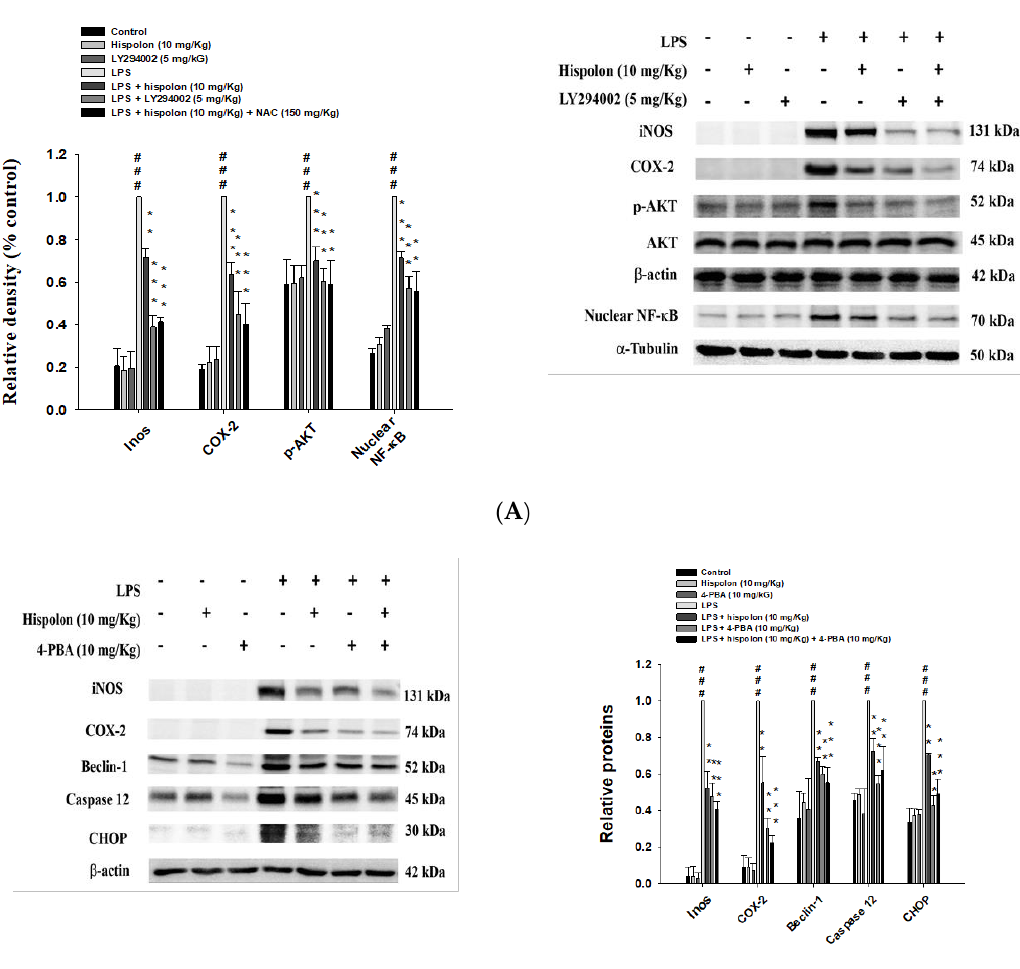
Figure 8. Hispolon, an AKT inhibitor (LY294002) ( A ) and an ER inhibitor (4-PBA) ( B ) regulated protein expression in LPS-challenged mice. Lung tissue extracts were subjected to Western blot analysis, using antibodies for iNOS, COX-2, Beclin-1, caspase 12 and CHOP. Data are represented as means ± S.E.M. (n = 3). ### p < 0.001, compared with the control group. ** p < 0.01 and *** p < 0.001 versus the LPS group.